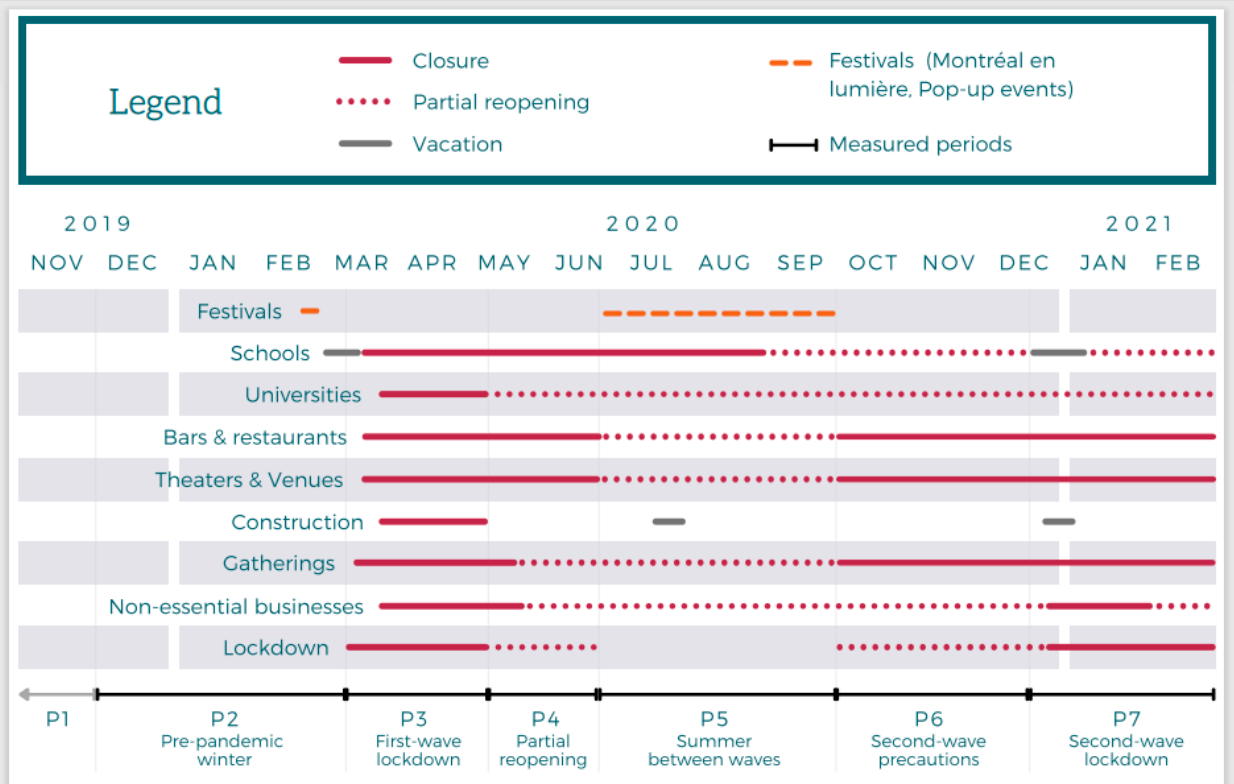
Figure 1. The center of the Quartier des Spectacles district with approximate measurement locations. Show are the main stage area (S1), and two separate areas within the Parterre, or secondary stage (S2, and S3). Additionally pictured is the local built context. Credit: Google Earth ©2021, image modified with labels by the authors. Table 2. Current measurement locations, earliest date.